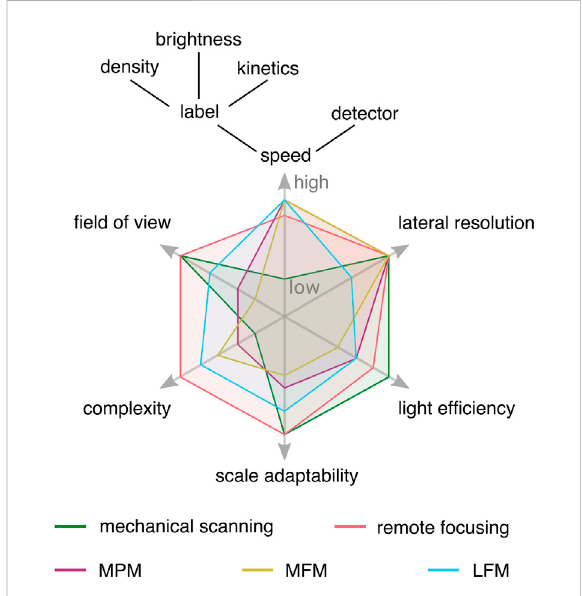
FIGURE 1 Conceptual experimental tradeoffs of selected volumetric imaging methods. Imaging speed is limited by the slowest component in the experiment, which can be the volumetric imagingmethod,labelingcharacteristics,ordetectorreadout speed. Lateral resolution refers to conventional microscopy, and the light ef fi ciency is mainly in fl uenced by the transmission ef fi ciency of optical components. Snapshot volumetric imaging techniques reduce constraints on imaging speed, opening the experimental design space, but come with their own